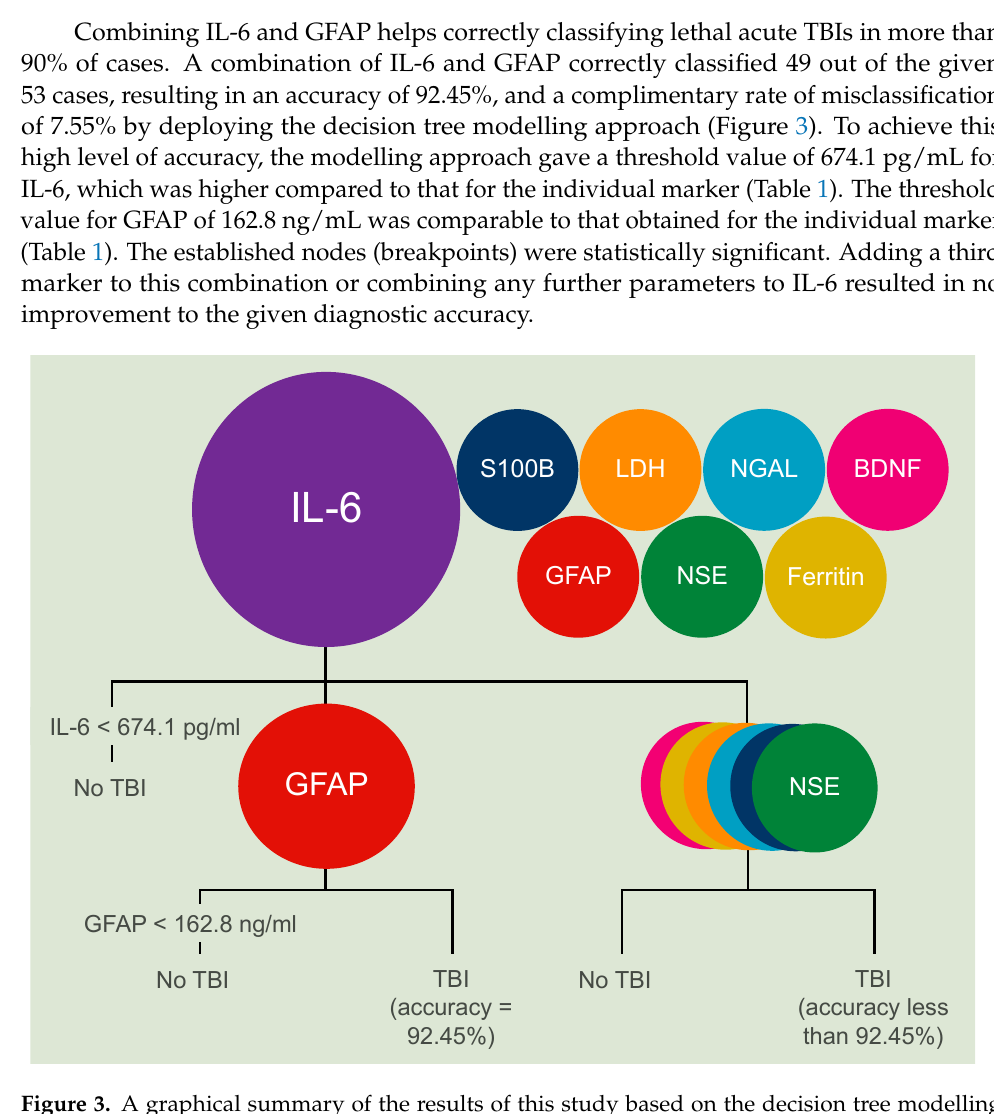
Figure 3. A graphical summary of the results of this study based on the decision tree modelling approach. From all the potential biomarker combinations in this study, the combination of IL-6 and GFAP resulted in the highest accuracy of 92.45% for the detection of an acute lethal